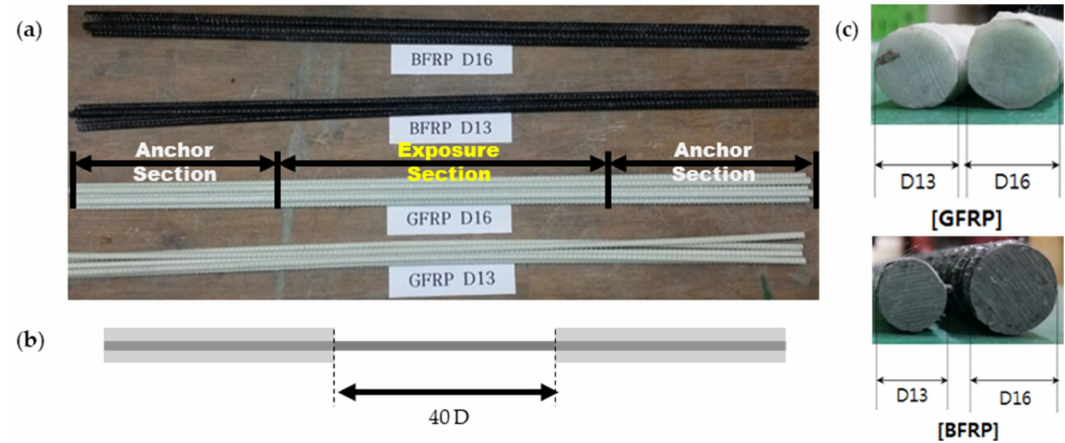
Figure 2. The specimens used in the test: ( a ) the shape of the GFRP and BFRP, ( b ) the length of the exposure section, and ( c ) the diameter of the GFRP and